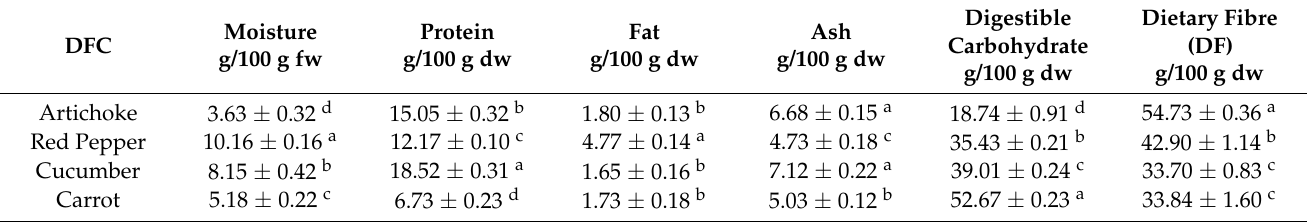
fw: fresh weight, dw: dry weight. Different lower-case letters in the same column indicate significant differences among DFC for each nutrient ( p < 0.05). IF’s content is slightly higher than that of SF in all DFCs studied, ranging from 53% to 61% of IF and from 38% to 47% of SF (Figure 1). According to other studies, the IF fraction